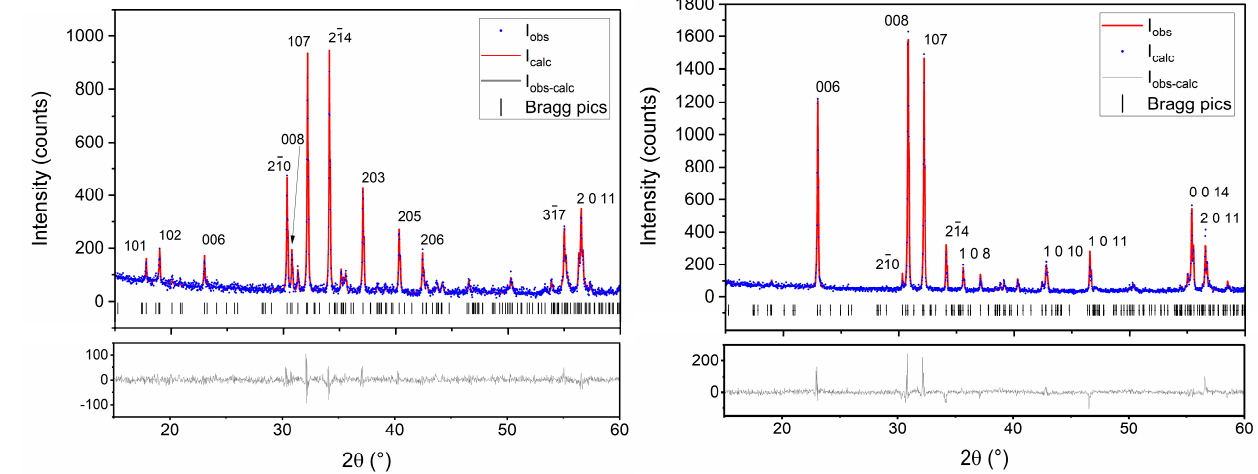
Figure 5. Diffraction pattern and Rietveld analysis of BaM ‐ 0 ( left ) and of BaM ‐ 100 ( right ). When comparing the X-Ray diffraction pattern of all the samples from BaM-0 to BaM- 100, it appears that (00l) basal reflections become stronger (Figure 5). This is explained by an increasing orientation of the crystallites [28]. More specifically the (008) reflection becomes stronger with the increasing goethite to hematite molar ratio, meaning that the rate of oriented BaM particles increases as well (Figure